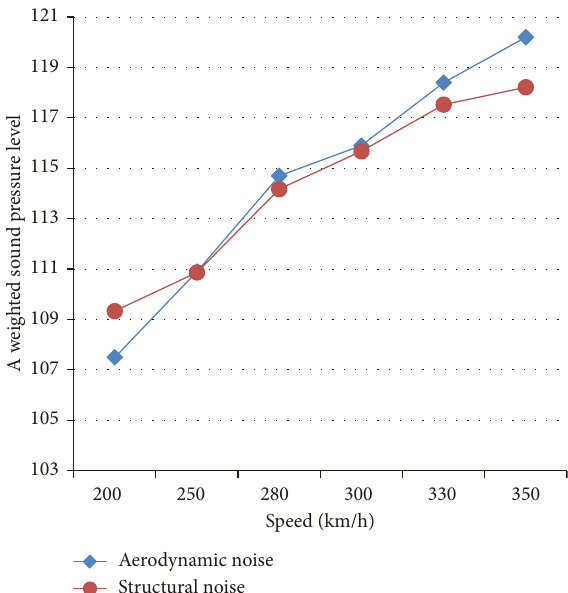
Figure 10: Structure radiated noise and aerodynamic noise con- tribution at each